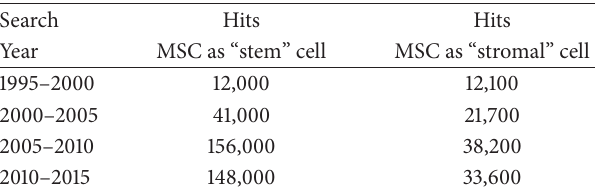
Table 1: Overview of studies published regarding MSCs using the term “stem cell” or “stromal cell” in the last 20 years accessed by a web search in July 2015 (Google Scholar). It seems that the term “stem cell” became more popular although the “stemness” was only shown in a more strict sense for MSCs involved in osteogenesis and bone repair.